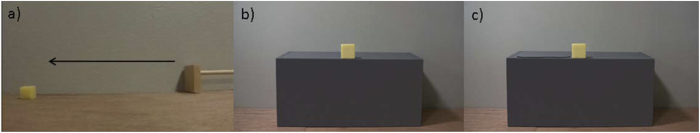
Familiarisation stimuli presented before each session.(a) videos, (b) core knowledge images, (c) string support images.